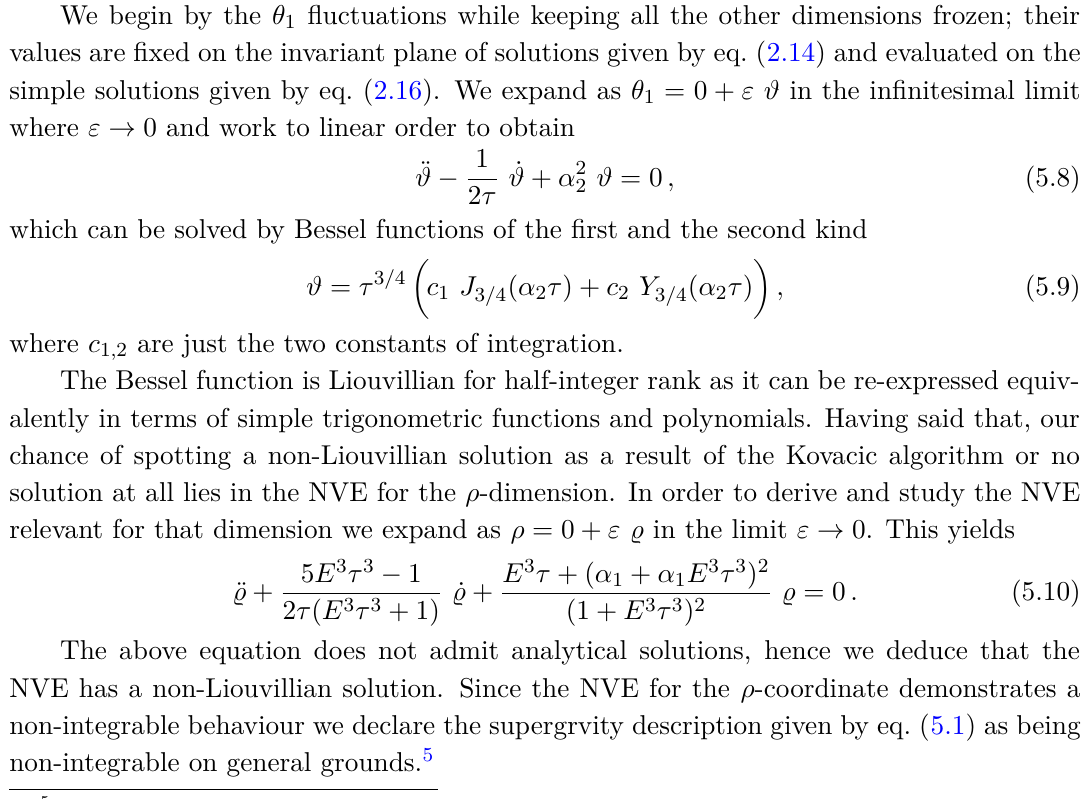
factor and finally the purple 0 and 1 /h differ only by a constant 0 0